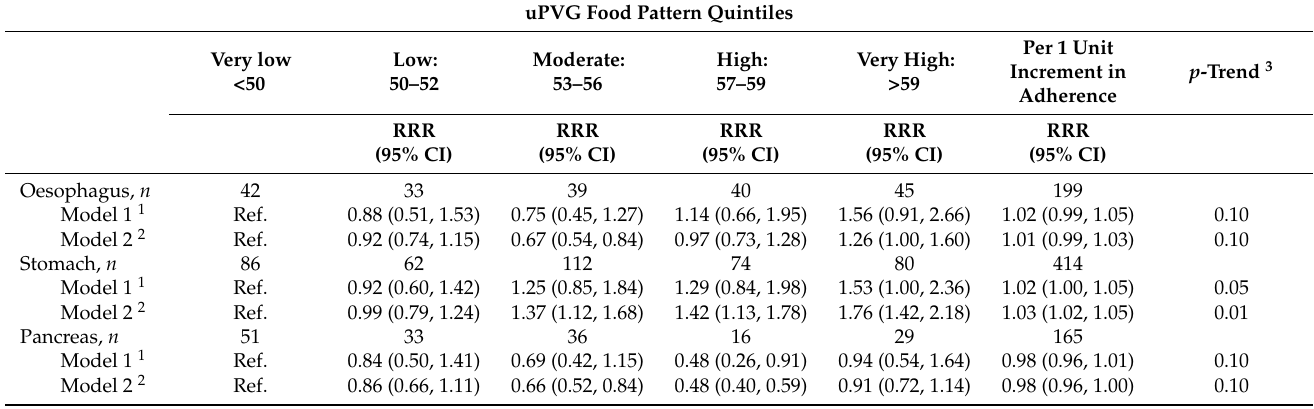
Table 5. Association between adherence to unhealthful PVG food pattern in quintiles and continuous (per 1 unit) and oesophageal, stomach, and pancreas cancer in participants of the PANESOES study ( n =